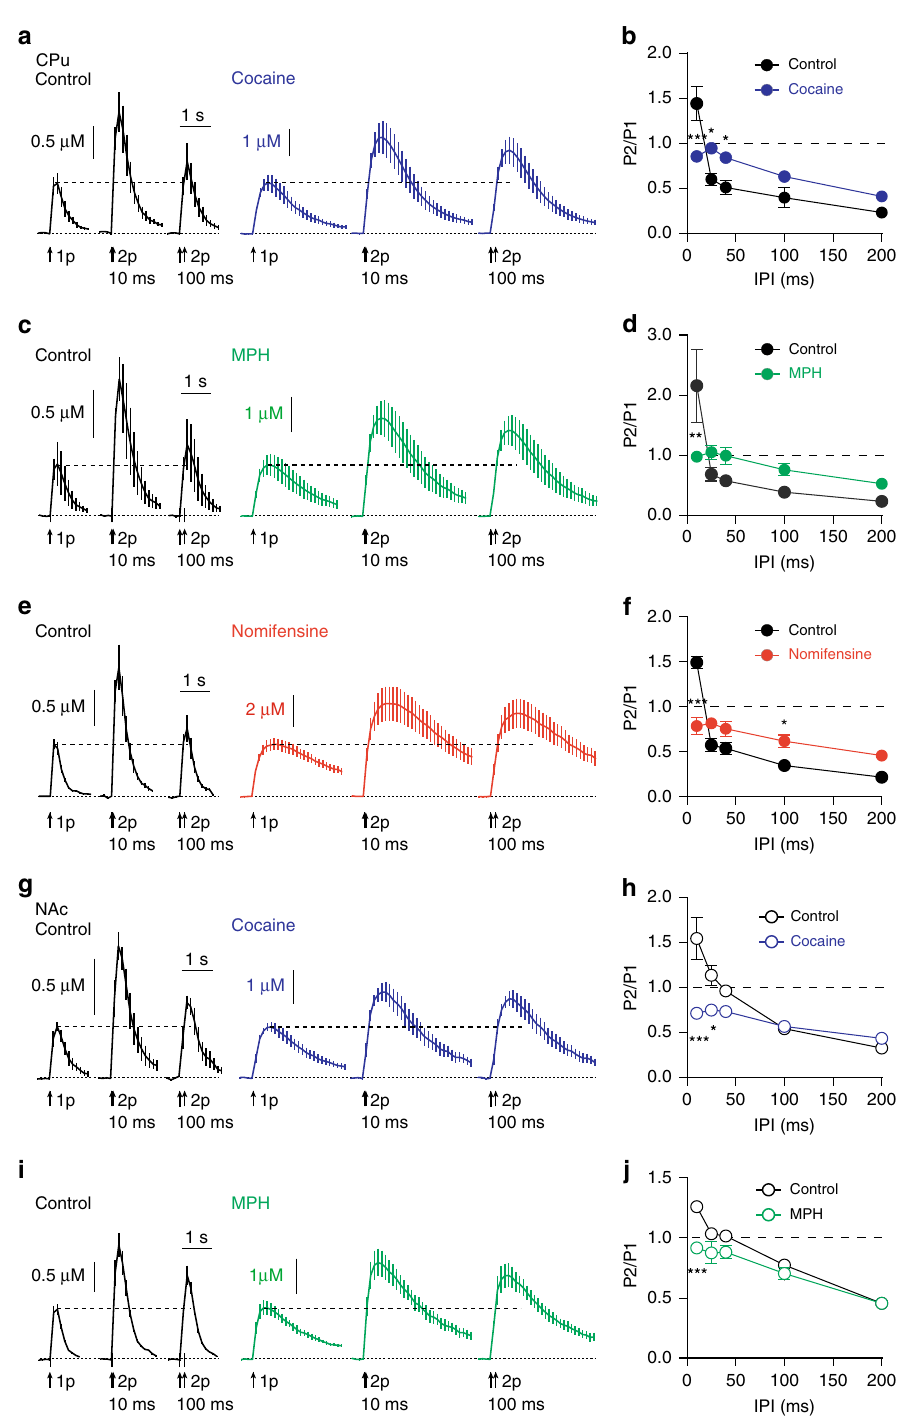
Fig. 6 The dopamine transporter regulates short-term plasticity of dopamine release. a , g Mean pro fi les of [DA] o transients elicited by single or paired electrical pulses in control conditions (black) or with 5 µ M cocaine (blue) in CPu ( a , n = 4) or NAc ( g , n = 4). b , h Mean P2/P1 against IPI in control conditions (black) and with cocaine (blue) in CPu ( b ) or NAc ( h ). c , i Mean pro fi les of [DA] o transients elicited by single or paired electrical pulses in control conditions (black) or with 5 µ M methylphenidate (MPH, grey) in CPu ( c , n = 5) or NAc ( g , n = 3). d , j Mean P2/P1 vs IPI in control conditions (black) and with MPH (green) in CPu ( d ) or NAc ( j ). e Mean pro fi les of [DA] o transients elicited by single or paired electrical pulses in control conditions (black) or with 10 µ M nomifensine (red) in CPu ( n = 3). f Mean P2/P1 vs IPI in control conditions (black) and with nomifensine (red) in CPu. Two-way ANOVA with Bonferroni ’ s test for post hoc comparisons; * P < 0.05, ** P < 0.01, *** P < 0.001. Error bars are ± SEM. Source data are provided as a